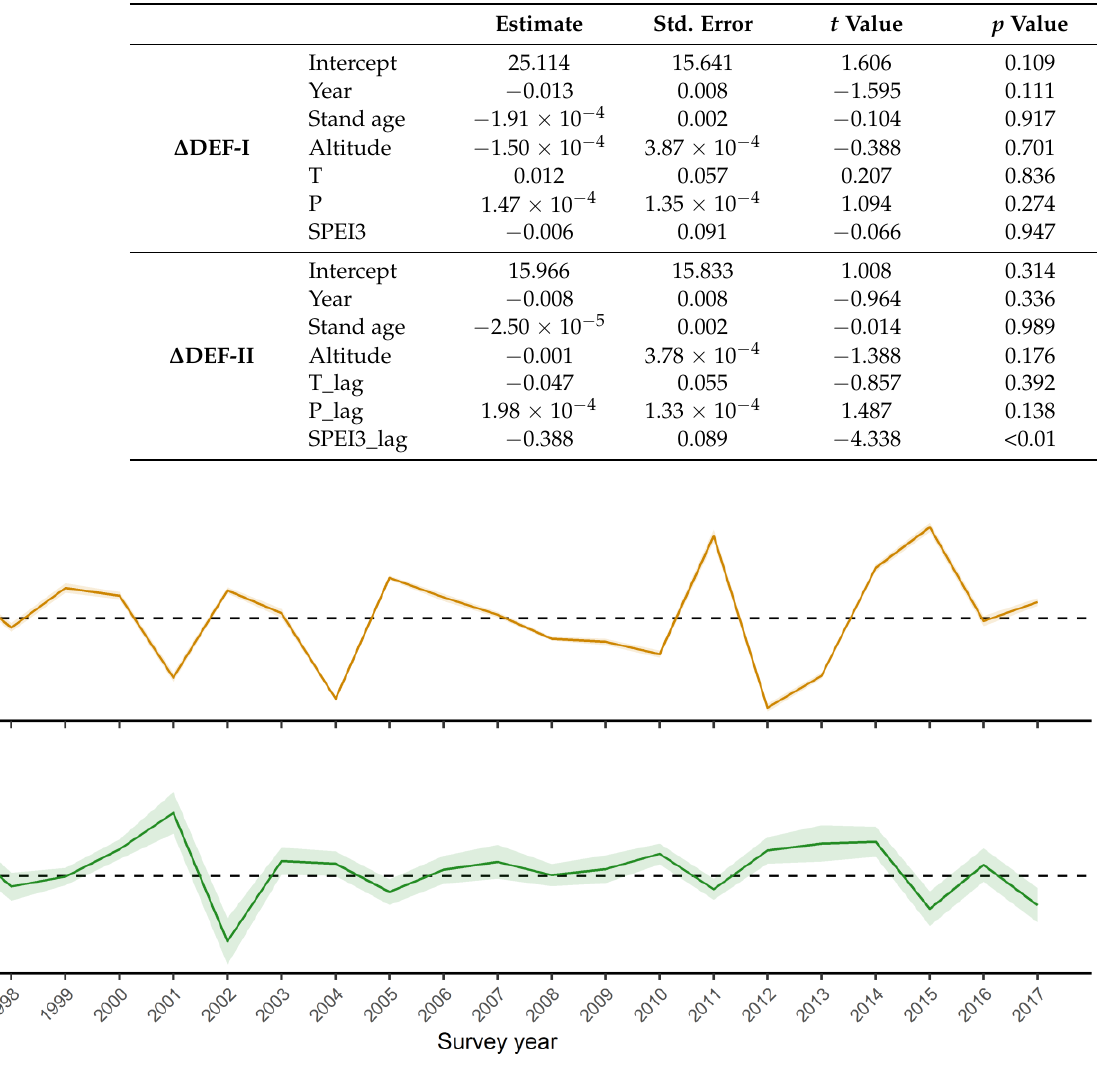
Figure 2. Inverse relationship between previous year SPEI (Standardized Precipitation Evapotranspiration Index) and defoliation change (ΔDEF i ) in Croatia from 1996–2017. ( a ) Previous year mean SPEI (orange line) and standard error (orange area), calculated on a time scale of three months. ( b ) Annual overall defoliation change (ΔDEF i ) mean (green line) and standard error (green area).